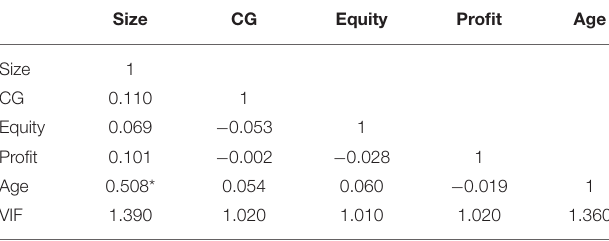
TABLE 9 | Results of correlation analysis and multicollinearity test.